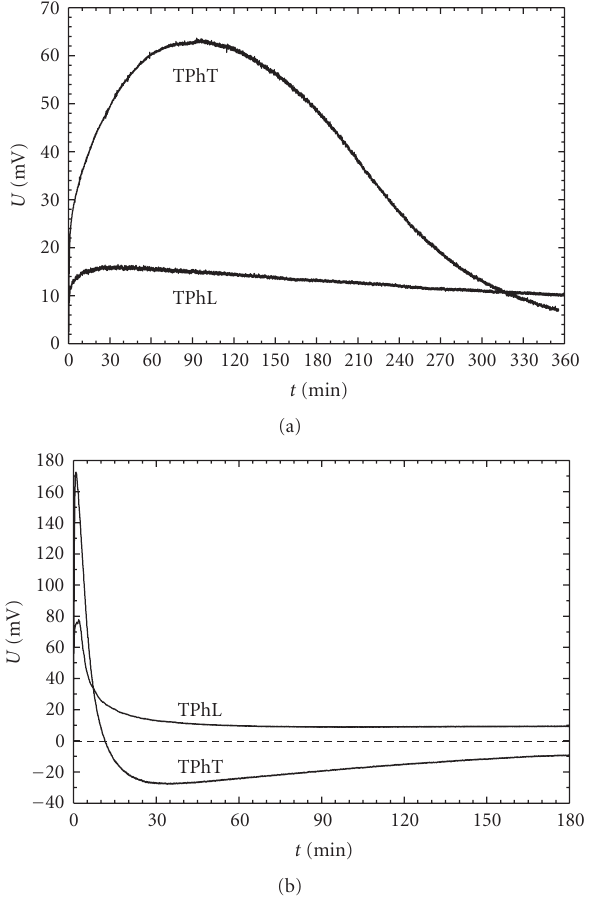
Figure 5: Time dependence of the membrane voltage for (a) 1% concentrations of the TPhT and TPhL; (b) 10% concentration of the TPhT and TPhL admixture in the measurement chamber.